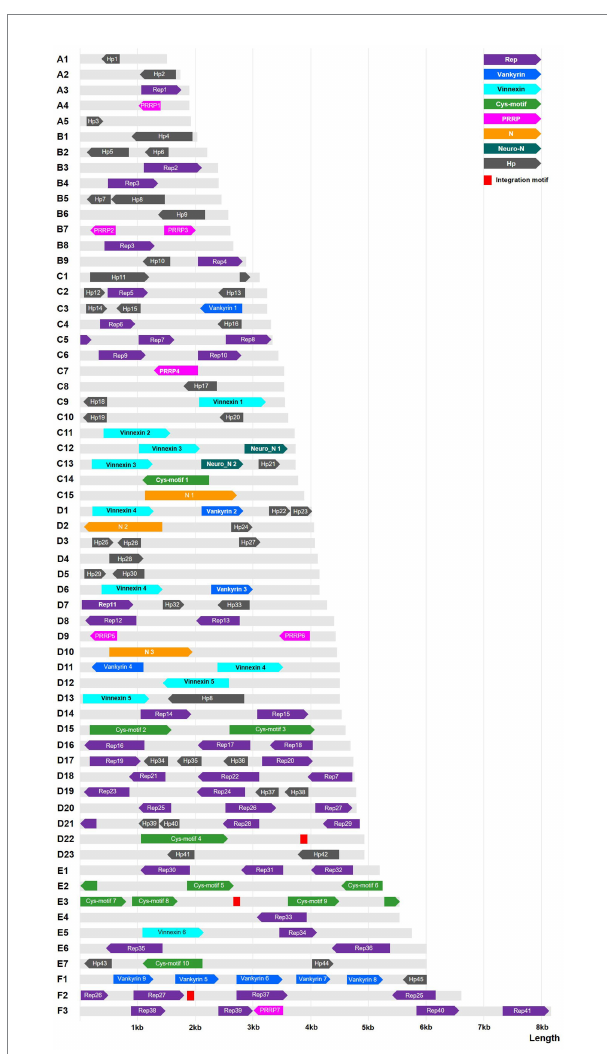
FIGURE 2 Graphical representation of the DfIV genome and its annotated genes, with 62 non-redundant (NR) circular genome segments shown as linear molecules. DfIV genome segments were 1.5–8.2 kp in length. Colored boxes show the sizes (length) and arbitrary locations of gene families, with directions indicated by the arrowheads on each box. Red boxes indicate integration motifs of the lepidopteran host genome. Gray regions represent non-coding DNA. Hp, hypothetical protein; PRRP, polar residue-rich protein 1; Rep, repeat element protein; Neuro-1, neuromodulin